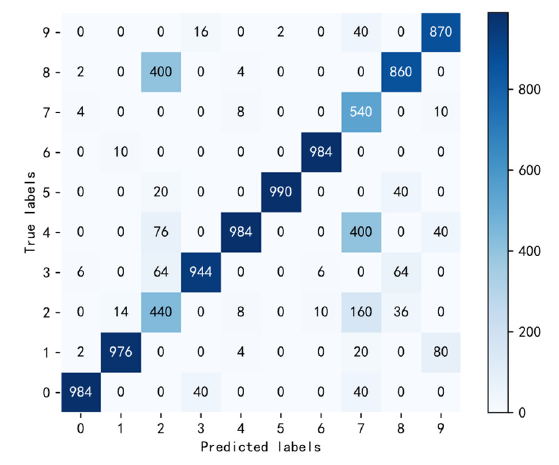
Figure 6. The classification results of samples with f d = 0.02.